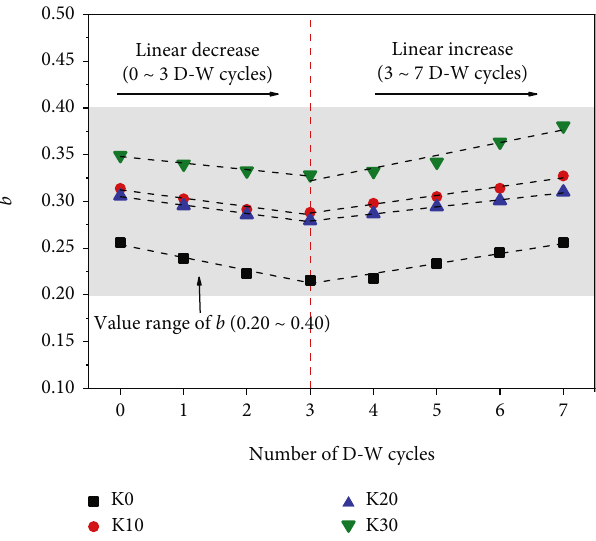
Figure 23: Relationship between permanent axial strain and D-W cycles number in the compaction